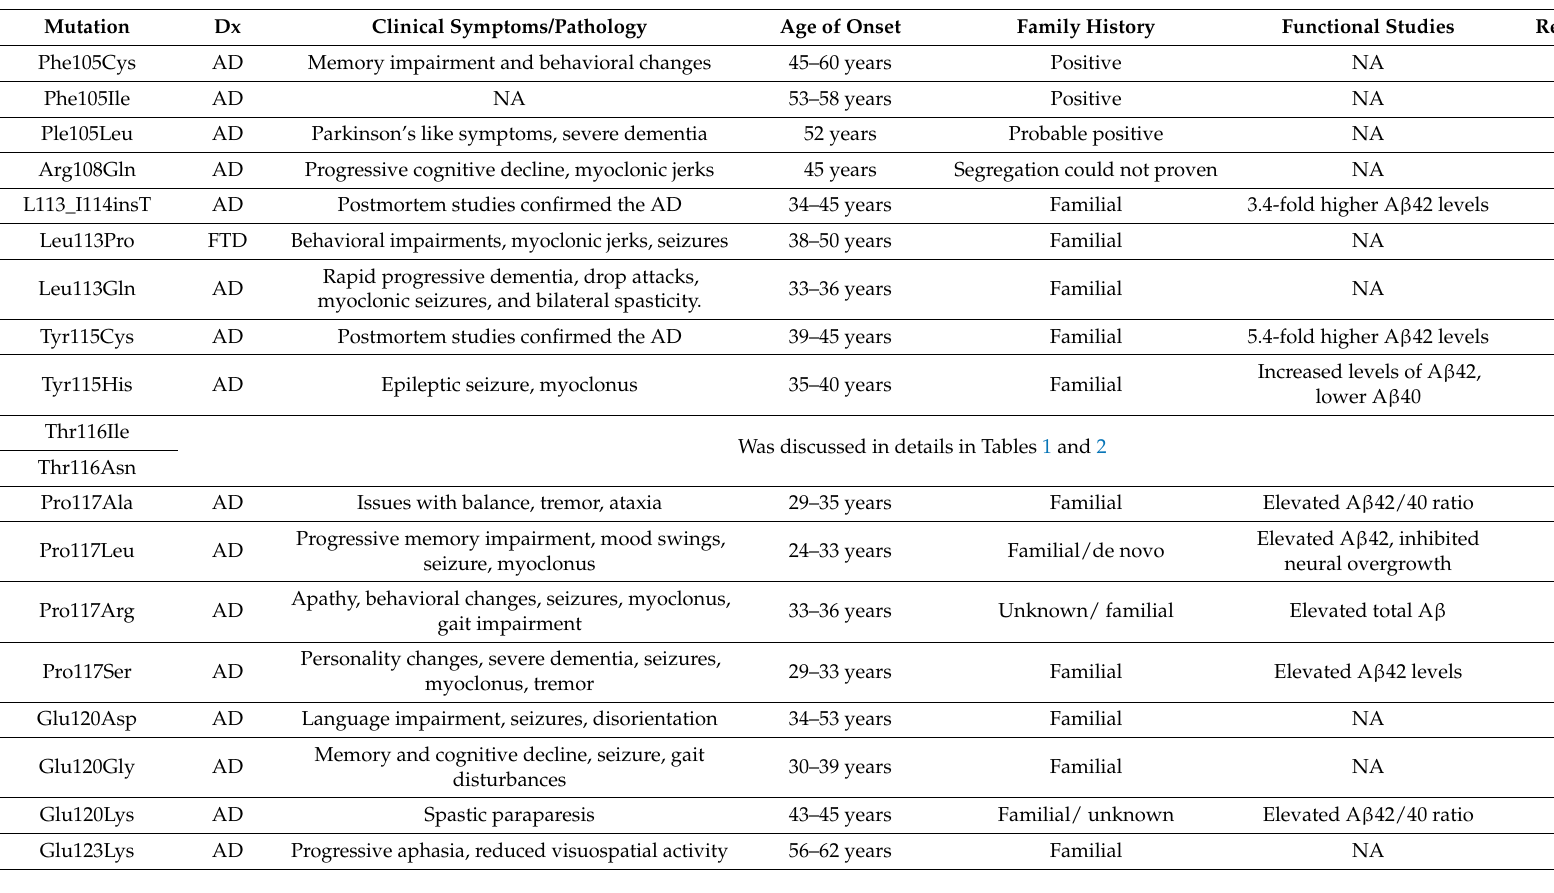
Table 3. Mutations, located in PSEN1